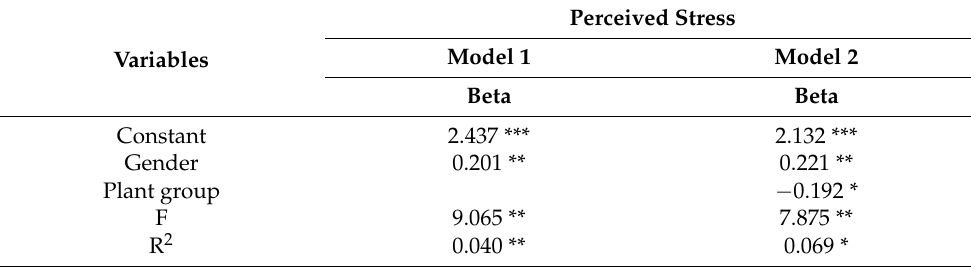
Table 3. Regression analysis results of the plant group (with-plants vs. without-plants) predicting perceived